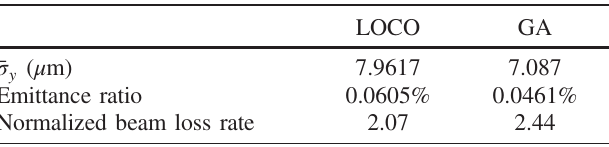
TABLE I. Comparison of optimized solutions from LOCO and